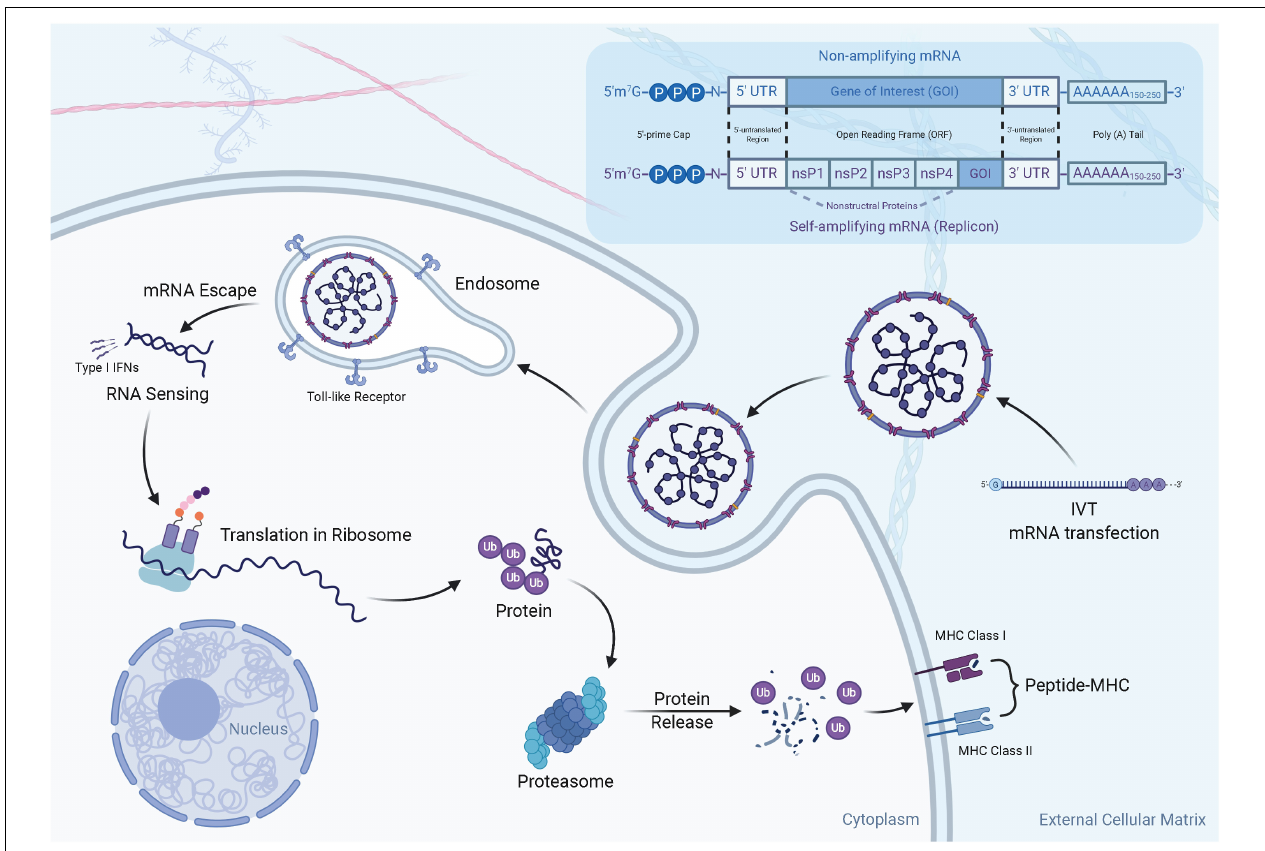
FIGURE 2 | The structure and mechanism of action of mRNA vaccines. (1) There are two widely acknowledged types of mRNA vaccines, namely non-amplifying mRNA and self-amplifying mRNA. The typical components of the two mRNAs are: the cap, untranslated regions (UTRs) of 5 (cid:48) and 3 (cid:48) , an open reading frame (ORF, including GOI) encoding the antigen, and Poly(A)n tail. Compared to non-amplifying mRNA, the size of self-amplifying mRNAs is fairly larger than non-amplifying mRNAs. For example, in α -virus-based replicons, the extra length comes from a large ORF encoding four non-structural proteins (nsP1-4). (2) In vivo transcribed mRNA (IVT mRNA) is obtained from a DNA template in a cell-free system. The IVT mRNA is transfected into dendritic cells (DC) by endocytosis. The mRNA is translated into antigenic proteins by utilizing a ribosome translation mechanism. The post-translational antigen protein undergoes post-translational modification and can play a role in the cells it produces. The antigen protein is degraded by the proteasome in the cytoplasm. The resulting antigen peptide is loaded onto the MHC molecule. The loaded peptide-MHC epitope complex appears on the cell surface, and after T cell receptor recognition and appropriate co-stimulation, an antigen-specific CD8 + T cell response is eventually